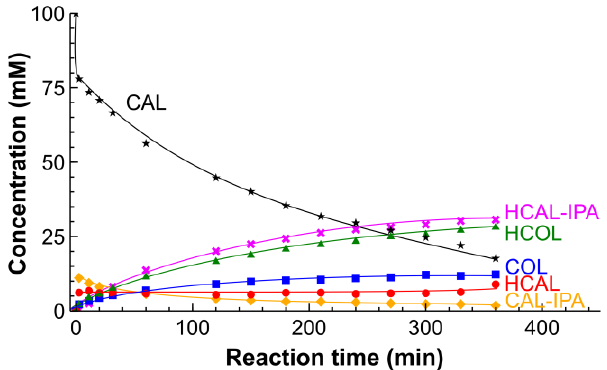
Figure 8. The outlet concentrations of the components obtained in the CAL hydrogenation as a function of residence time in a batch reactor. Reaction conditions: 0.1 g 12 wt % Pt/SiO 2 , H 2 pressure 10 bar, 90 °C, 0.1 M CAL in IPA.